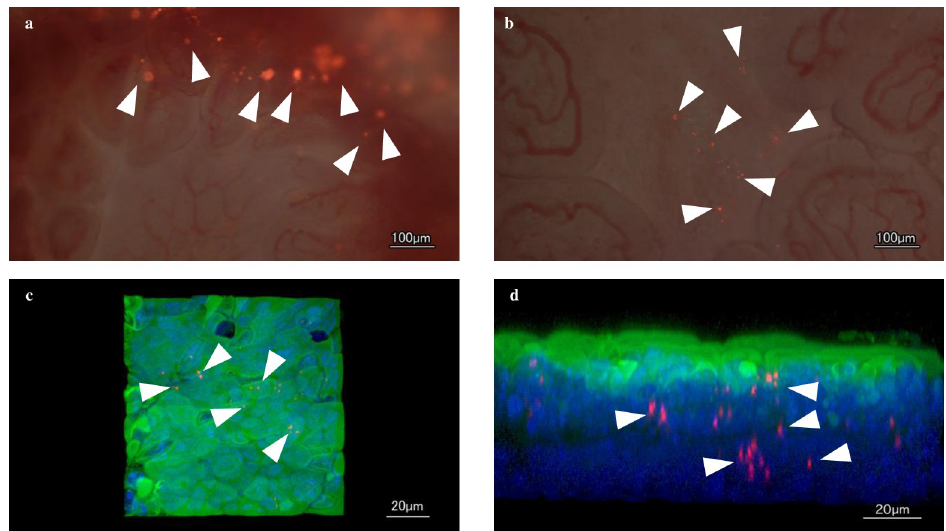
Fig 3. Microscopic images of the Peyer’s patch in mice after LAB and d-LAB administration and Peyer’s patches images after d-LAB administration with cLSM. n-LAB ( a ) or d-LAB ( b ) stained with Cy3 and Peyer’s patches were imaged using a fluorescence microscope. The uptake of d-LAB by Peyer’s patches after d-LAB administration was imaged using cLSM [( c) ; image from the lumen and (d) ; cross-sectional image]; actin was stained with phalloidin and nuclei were stained with DAPI. The white triangular arrow shows the bacteria. cLSM, confocal laser scanning microscopy; d-LAB, dispersed lactic acid bacteria; n-LAB, non-treated lactic acid bacteria. https://doi.org/10.1371/journal.pone.0251784.g003 and n-LAB groups did not return to their pre-infection body weight even on day 14 post-infec- tion. There were no differences in body weight change in each group during the 7-day admin- istration period.